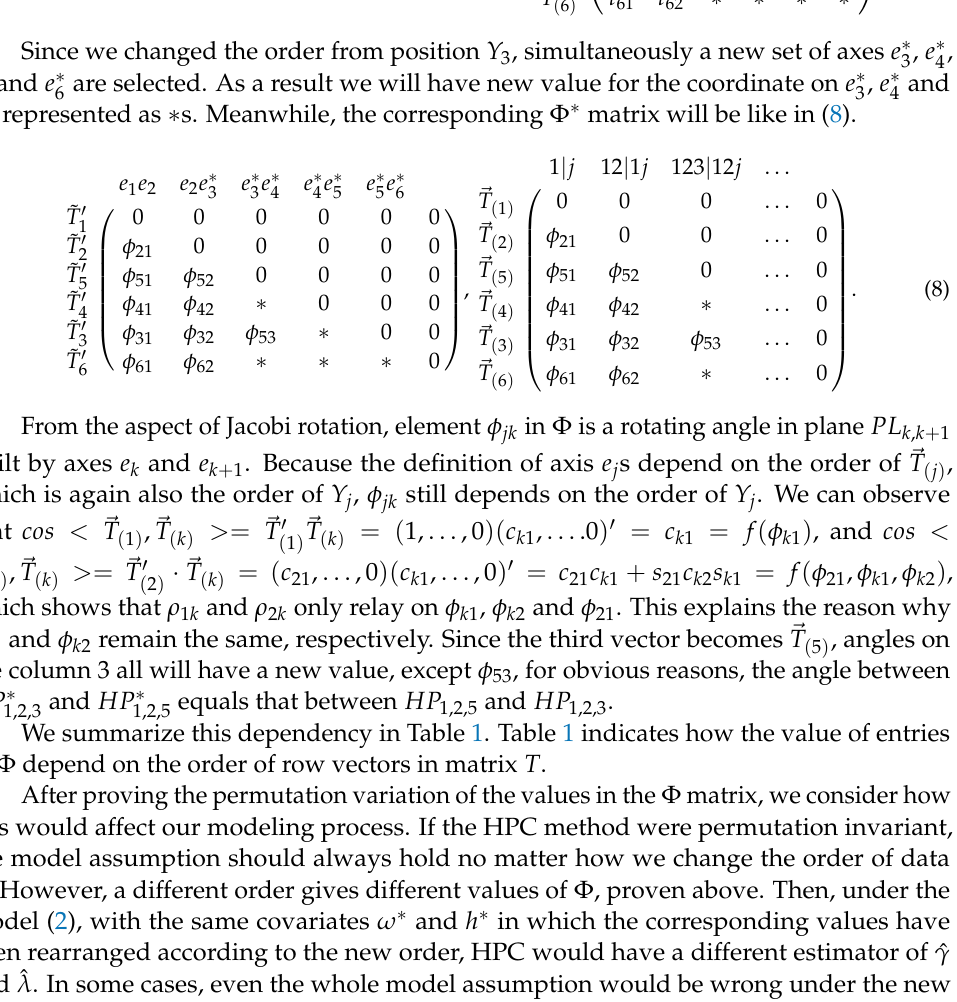
Table 1. Dependence between entries in Φ and row vectors in T . For example, 1, 2, 3, p means element φ p 3 , at row p column 3 in Φ depends on the first, second, third and p th row vectors in T . col1 col2 col3 ... colp-1 colp row1 0 0 0 ... 0 0 row2 1, 2 0 0 ... 0 0 row3 1, 3 1, 2, 3 0 ... 0 0 . . . . . . . . . . . . . . . . . . . . . 1, 2, 3, ..., rowp 1, p 1, 2, p 1, 2, 3, p ... p − 1, p